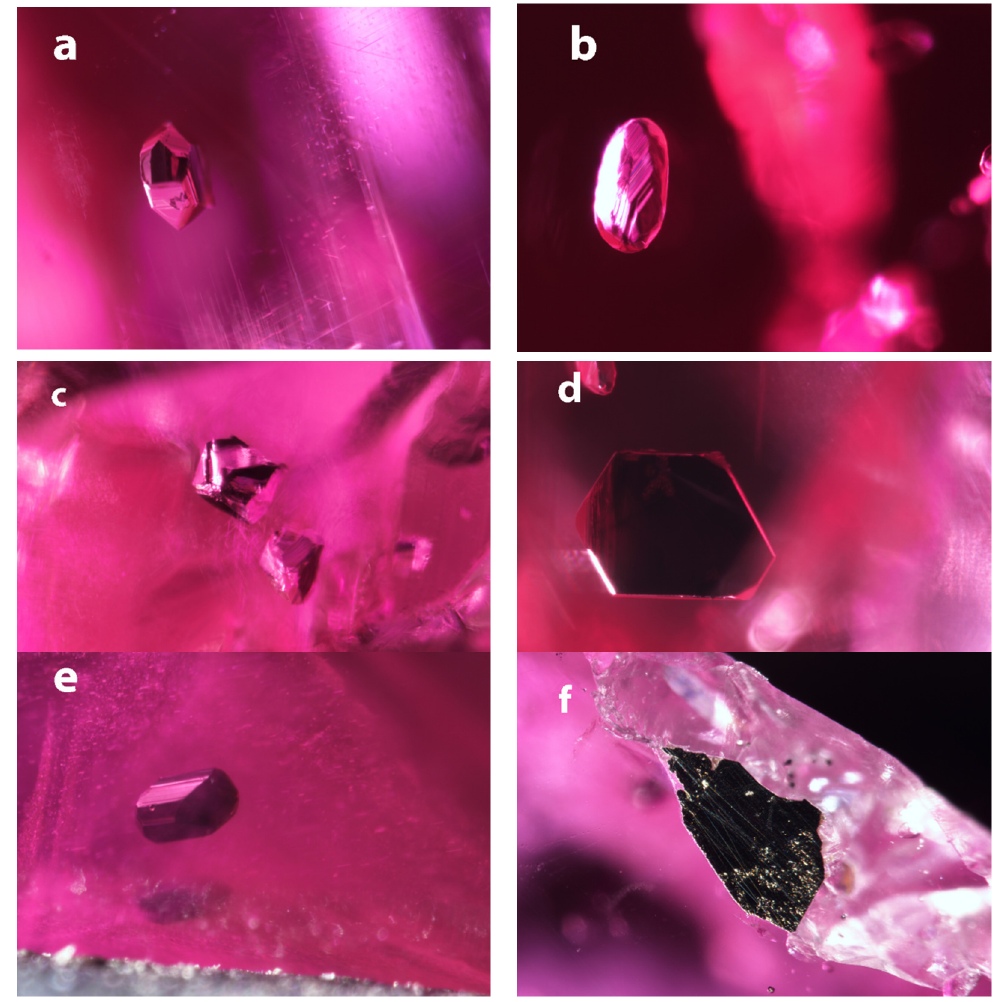
Figure 1. Images of the inclusions in the Mogok rubies. ( a ) Opaque inclusion in A1, showing well-formed crystal faces. FOV: 1.2 mm; ( b ) Opaque inclusion in A2 has more rounded appearance due to the terraced angular features. FOV: 1.01 mm; ( c ) Opaque inclusions in A3 exhibit almost a bipyramidal shape reminiscent of a cubic crystal structure. FOV: 1.2 mm; ( d ) Opaque inclusion in A3 has a very flat, (pseudo?) hexagonal outline. FOV: 0.85 mm; ( e ) Opaque inclusion in A5 shows well developed crystal faces and a slightly elongated blocky crystal shape. FOV: 0.85 mm; ( f ) The opaque minerals associated with sample A6 are an irregular mass, attached to the ruby and surrounded by carbonates. FOV: 1.44mm.